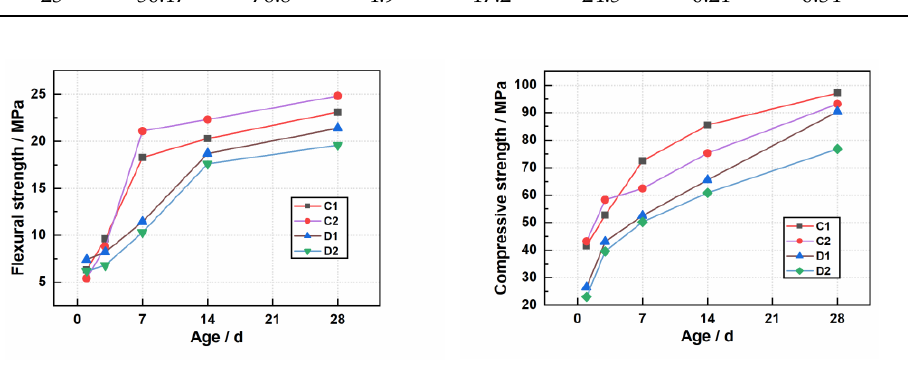
Figure 2. The effect of EVA of the material on the strength: ( a ) flexural strength; ( b ) compressive strength.